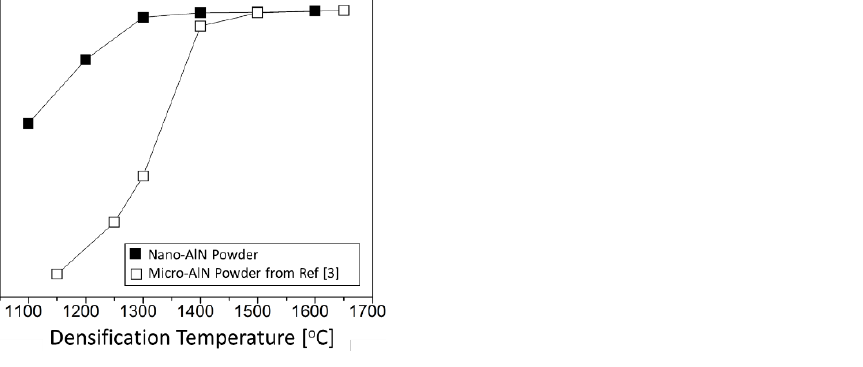
Figure 4. The effect of CAPAD temperature on relative density of samples densified from. Black square dots show the powder nitridated at 1200 °C for 18 h. Open square dots shows the commercial AlN powder [3].